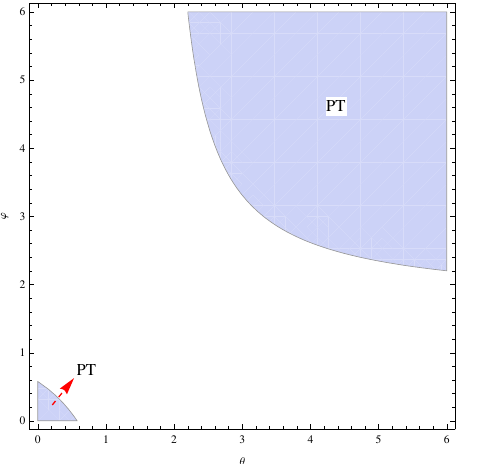
Figure 3. (Color online) The blue regions show the phase transition regimes for the